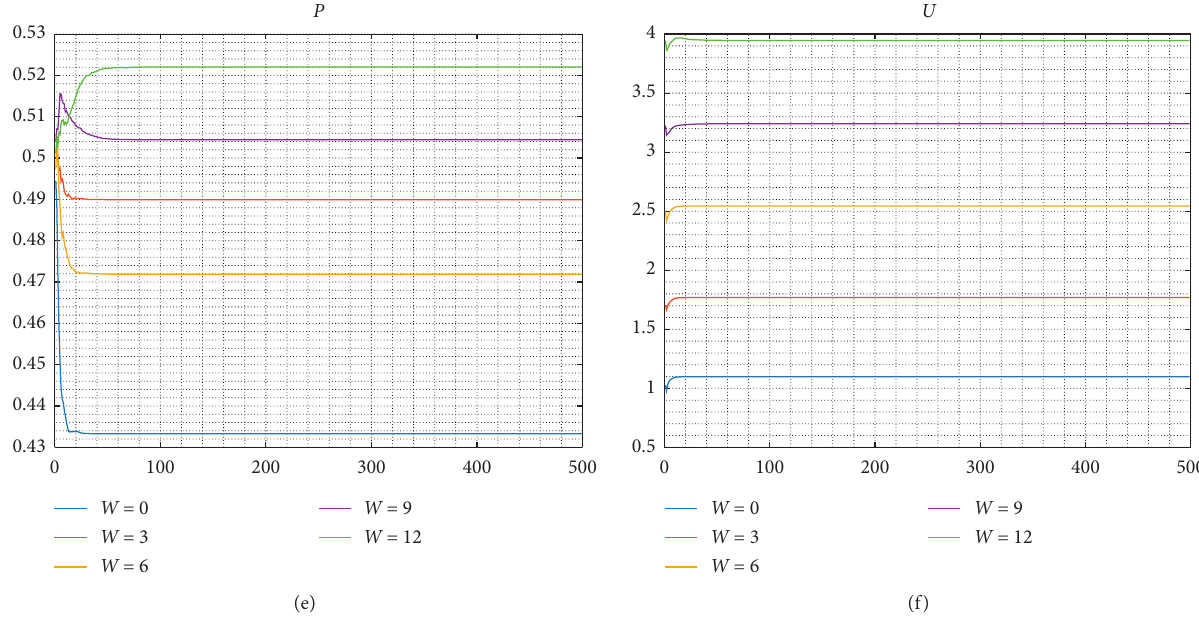
Figure 6: The simulated results of situation 4. (a) P (Case 1). (b) U (Case 1). (c) P (Case 2). (d) U (Case 2). (e) P (Case 3). (f) U (Case 3).